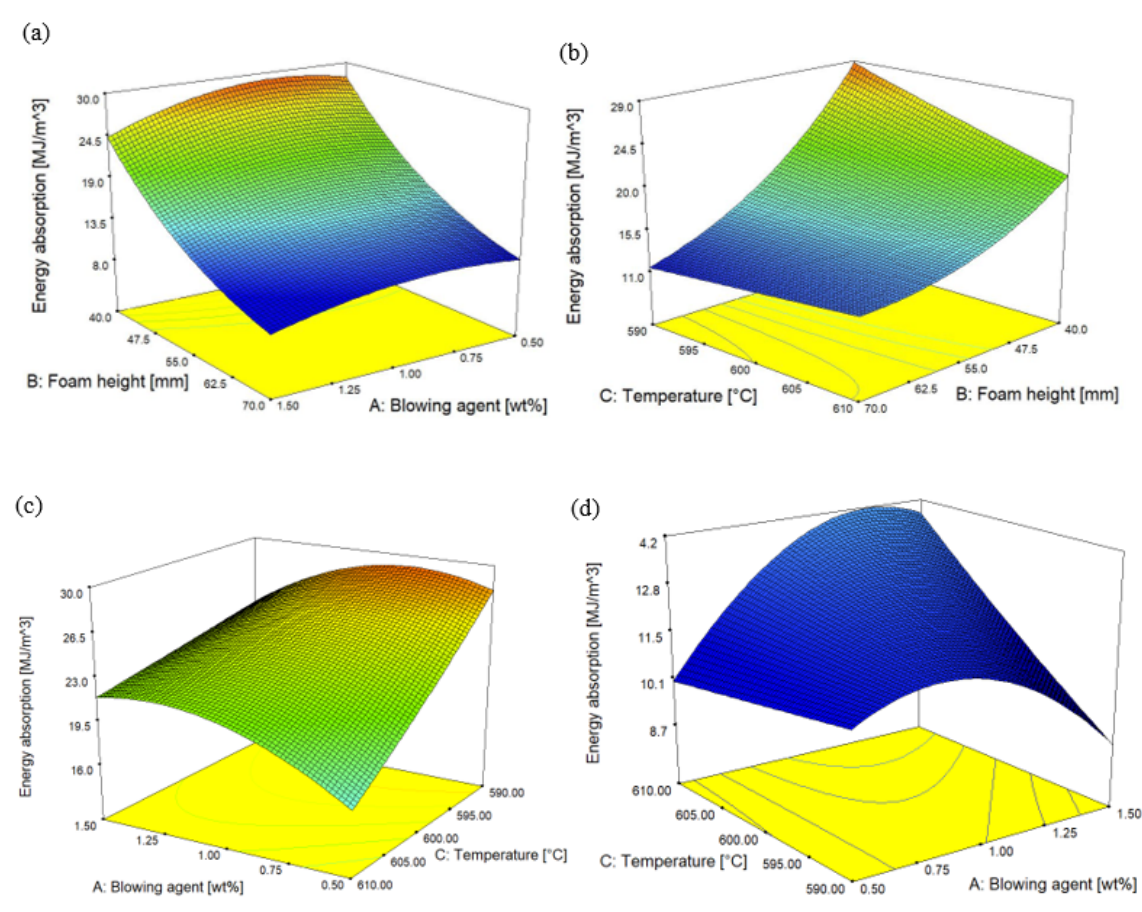
Figure 6. ( a ) Influence of foam height and blowing agent (wt%) on energy absorption for constant foaming temperature of 590 °C. ( b ) Influence of foam height and temperature on energy absorption for 1 (wt%) TiH 2 . ( c , d ) Influence of the foaming temperature and blowing agent (wt%) for constant foam heights of 40 mm and 70 mm, respectively.